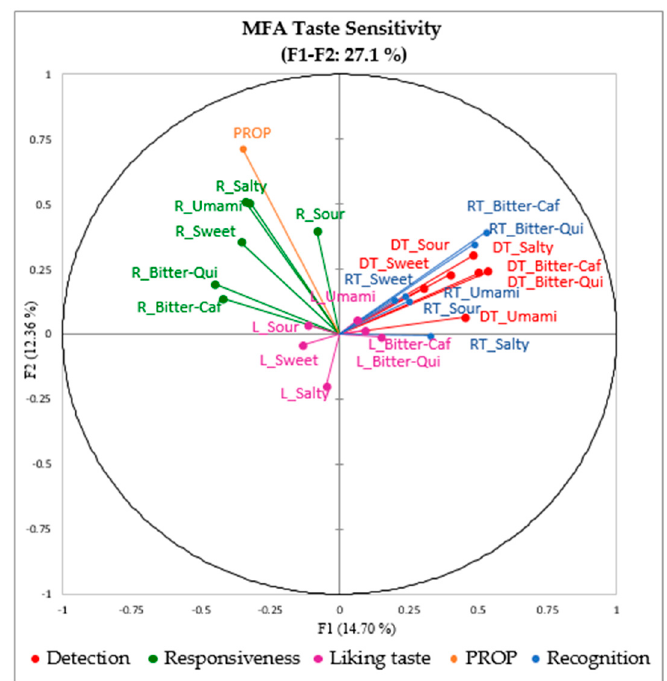
Figure 1. MFA of taste sensitivity and liking measures, included as supplementary variables (R = responsiveness, DT = detection threshold, RT = recognition threshold, L = liking of taste